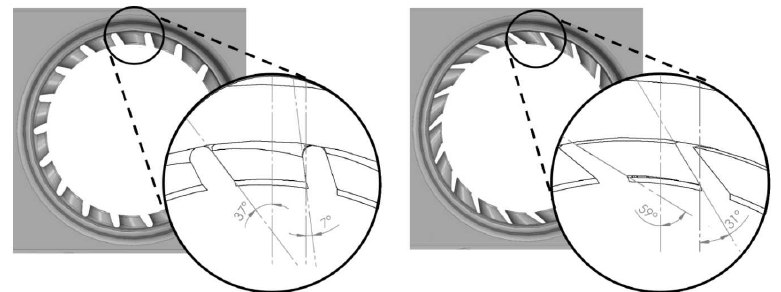
Figure 17. Schematic of the new geometry for the intake ports.